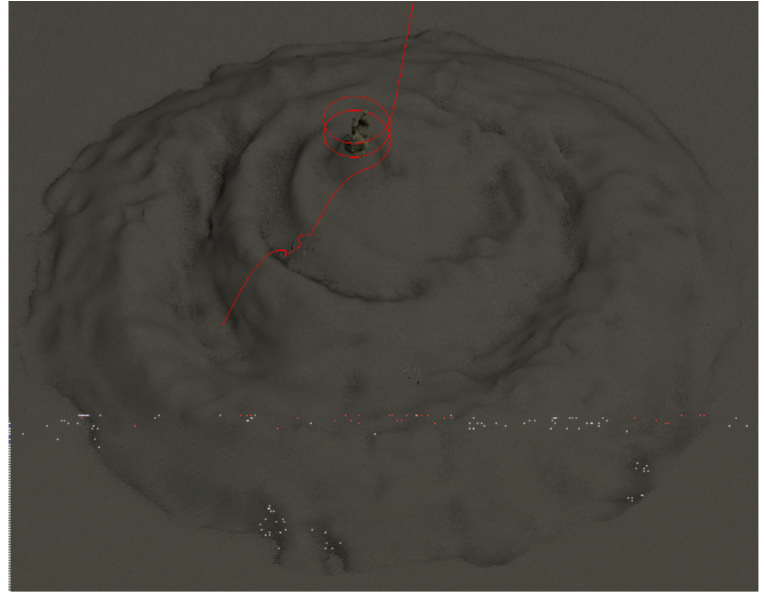
Figure 5. The path in the TAG mound.